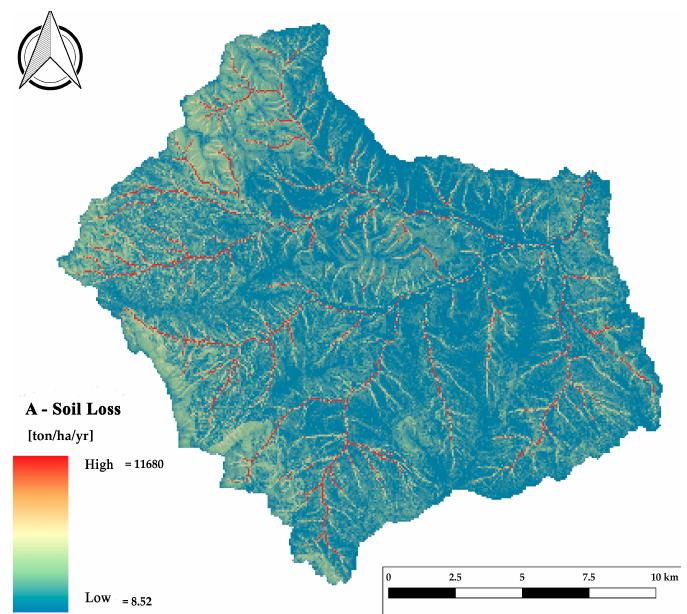
Figure 8. Unit Soil Loss Equation map for the Camastra Basin based on Revised Universal Soil Loss Equation (RUSLE) model, in t/ha/yr. Table 3. Univariate Statistics of Soil Loss raster map.